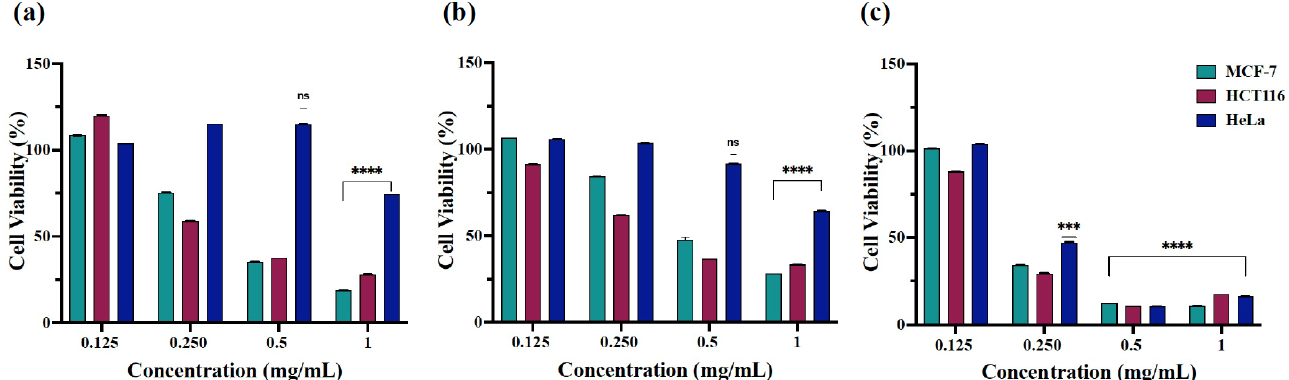
Figure 7. Cell viability (%) of MCF-7, HCT116 and HeLa cells treated with β -Nb 2 ZnO 6 nanoparticles ( A ). The graph shows the cytotoxic effect of β -Nb 2 ZnO 6 nanoparticles ( A ) as highly significant (****) when compared with untreated (control) cells, ( a ) treatment for 24 h, ( b ) 48 h and ( c ) 72 h. P value is set at <0.05 (* if P ≤ 0.05, ** if P ≤ 0.01, *** if P ≤ 0.001, **** if P ≤ 0.0001).